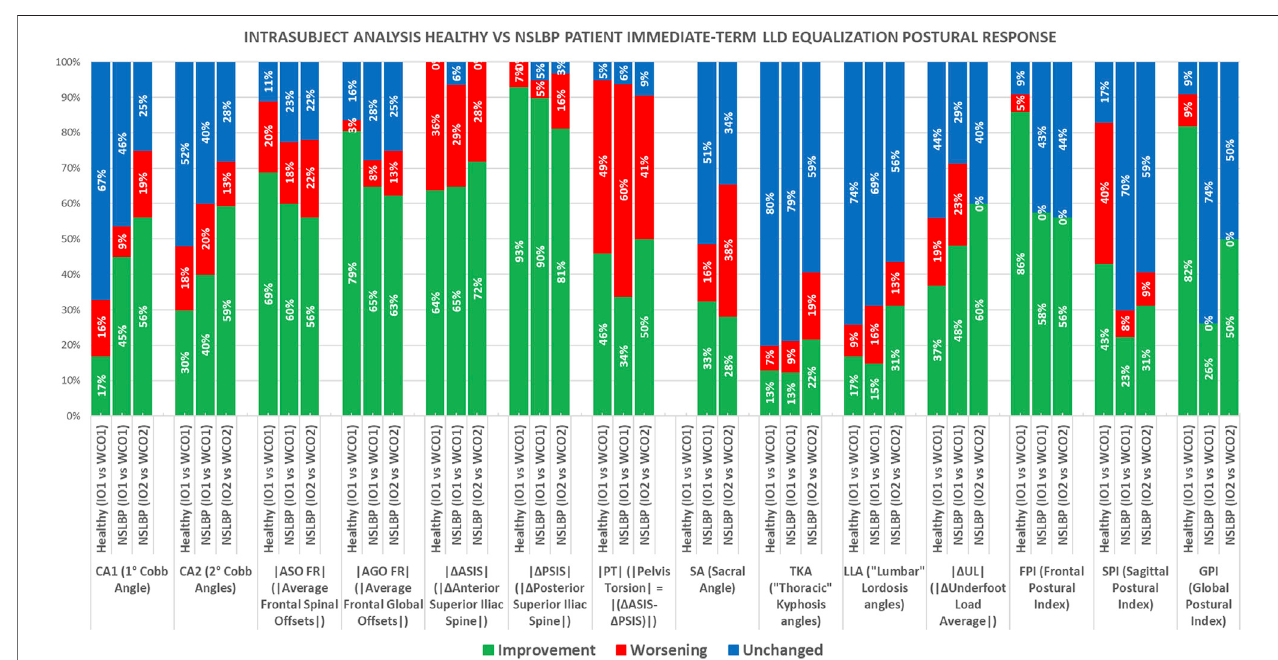
FIGURE5| Intrasubjectanalysishealthyyoungadults ’ vs.NSLBPpatients ’ pooleddataimmediate-termLLDequalizationposturalresponsecomparisons:IO 1H vs. WCO 1H ,IO 1NSLBP vs.WCO 1NSLBP ,IO 2NSLBP vs.WCO 2NSLBP .Healthyyoungadults ’ pooleddatafortheIO 1 vs.WCO 1 (datafrom(D ’ Amicoetal.,2017b)).IO 1 (IOat fi rst evaluation); WCO 1 (WCO at fi rst evaluation); IO 2 (IO at control session); WCO 2 (WCO at control session). Subscript H indicates healthy young adults; subscript NSLBP indicates nonspeci fi c low back pain patients.